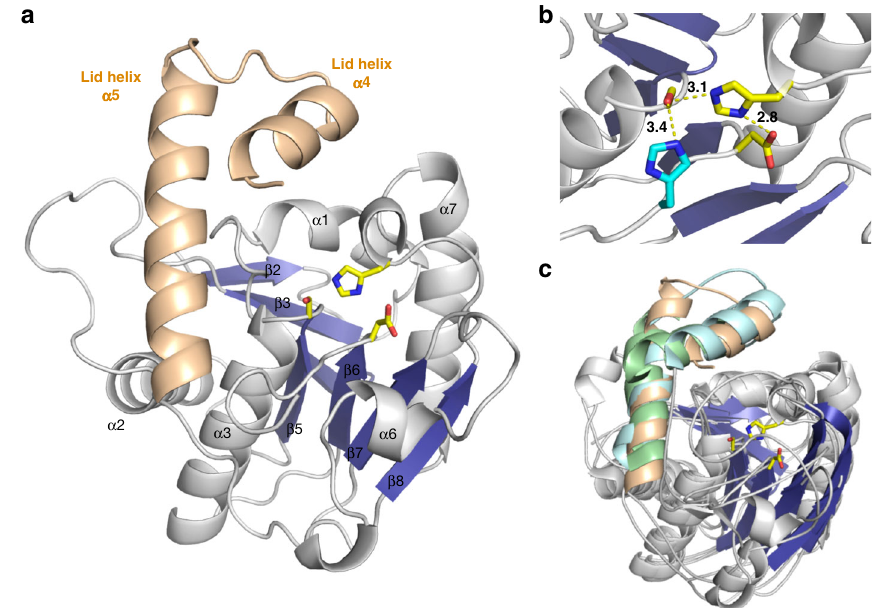
Fig. 2 Structure of NocTE. NocTE forms a traditional α / β hydrolase fold observed with NRPS thioesterase domains. a The lid helices α 4 and α 5 are highlighted in wheat. The catalytic triad residues Ser1790, His1901, and Asp1806 are shown in yellow. In the absence of ligands, the N-terminal portion of helix α 4 is disordered. b Catalytic triad residues are highlighted in yellow, while one side-chain orientation of His1808 is shown in cyan. c Superposition of PksA TE (PDB 3ILS) and Srf TE (2VSQ) with NocTE, showing similar lid helix positions. The lid helices of PksA are colored cyan and the helices of SrfA-C are colored green. Loop smoothing is used in ( c ) for clarity